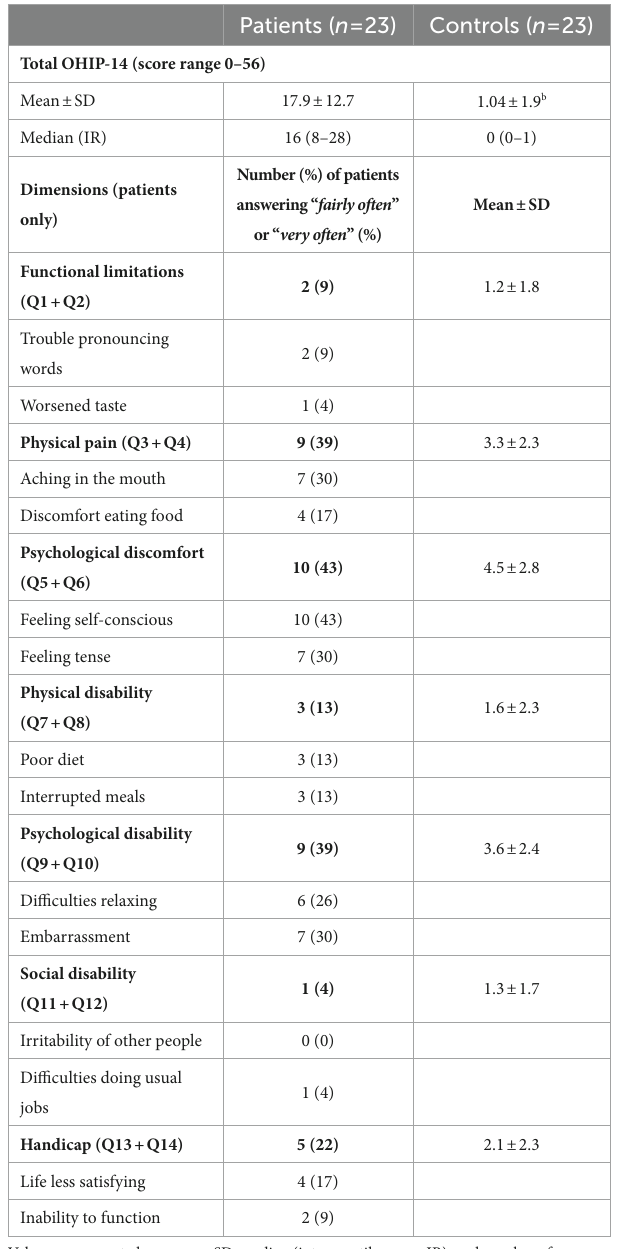
TABLE 9 The Oral Health Impact Profile-14 total score (OHIP-14), dimension scores and frequency of patients answering either “fairly often” or “very often” on the specific OHIP-14 dimensions (shown in bold) and the corresponding questions